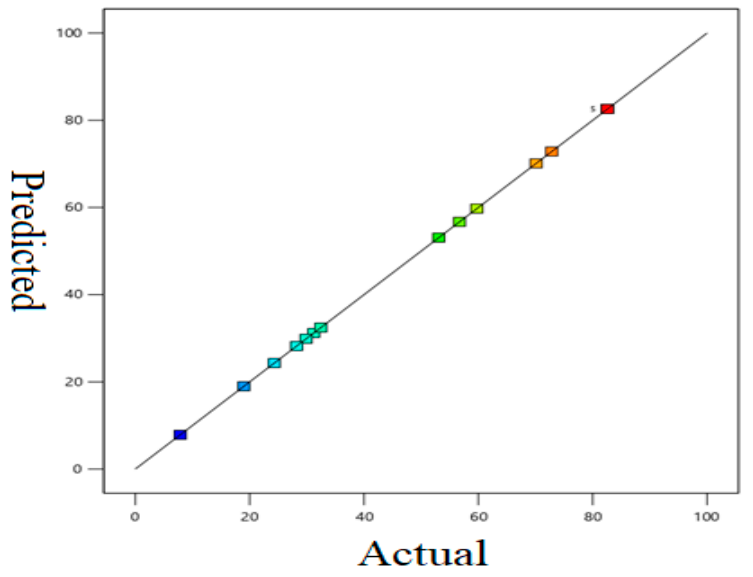
Figure 5. Plot of the experimental run in different colors refer to Table 1: % observed response versus % predicted response (blue color showed lowest and red color showed highest % removal of citalopram).